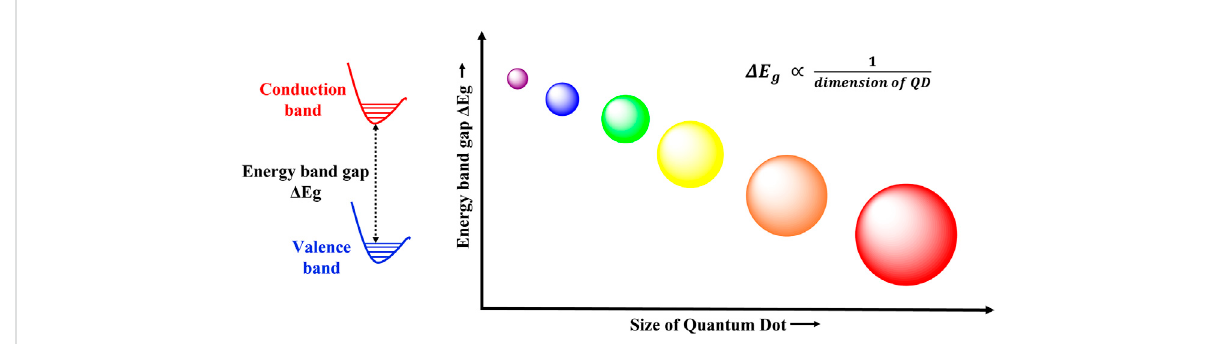
FIGURE 2 Sizedependent photoluminescenceinQDs.The bandgapenergyandthesizeofquantumdots followsan inverserelationship.Therefore,QDs with large band gap energies have smaller radii, while small band gap QDs are larger in size.